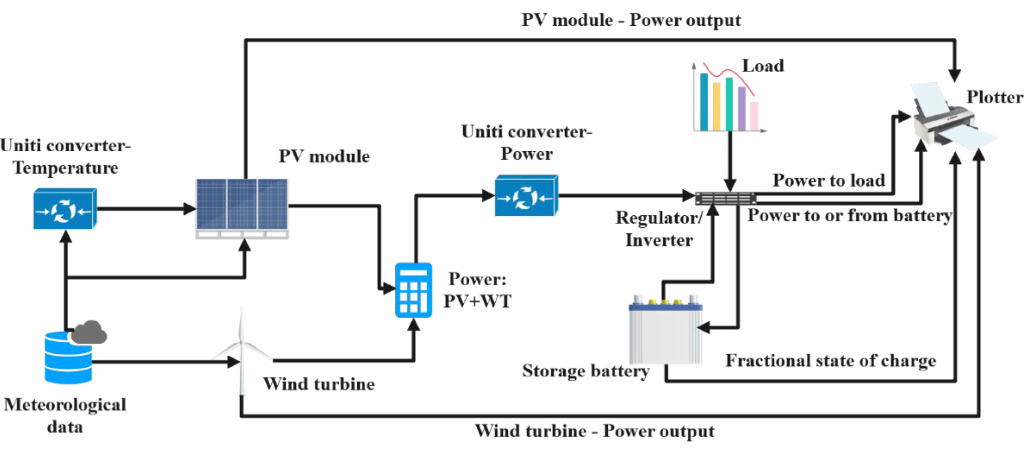
Figure 1. Model of standalone hybrid WT/PV system by